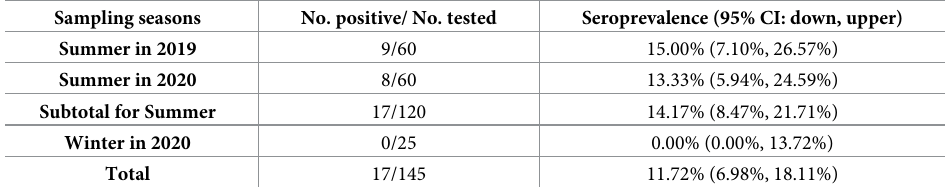
Table 2. Seroprevalence of sheep and goats TB for the samples from Gansu province. Sampling seasons